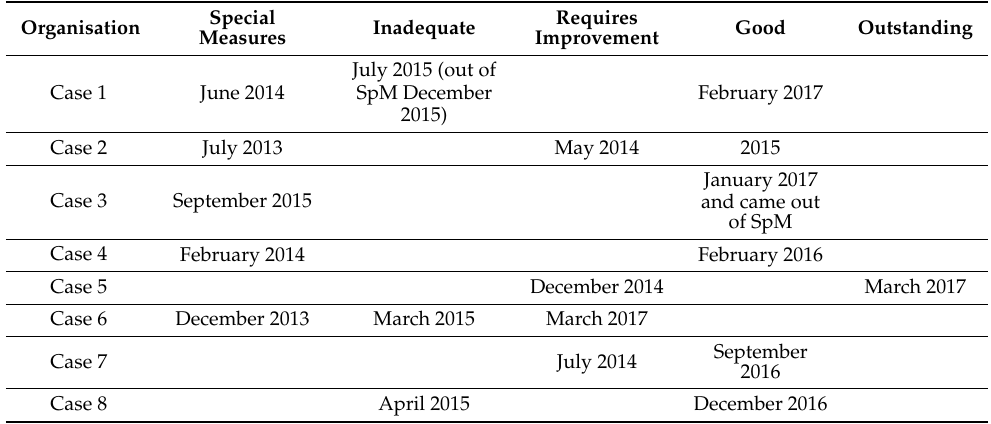
Table 3. The selected case organisations’ journey from special measures (adapted from [20]). Key: SpM—special measures.